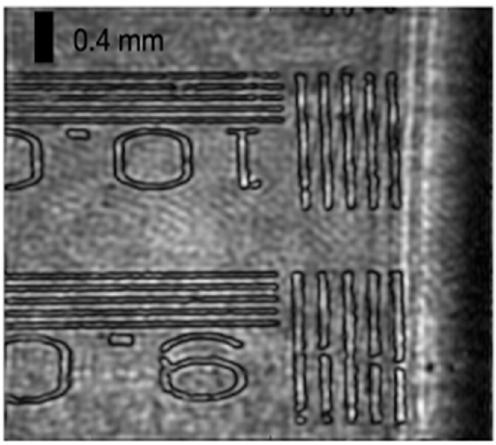
Figure 7. Amplitude reconstruction of a hologram recorded of a resolution card to determine lateral resolution.